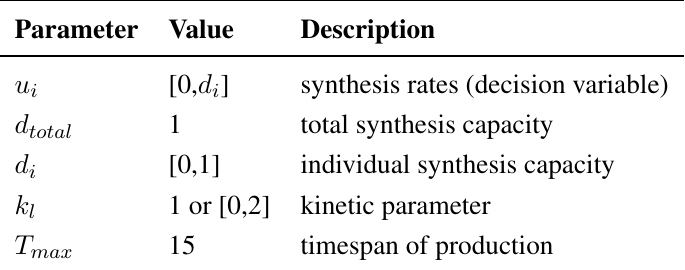
Table 3. Parameter and variable